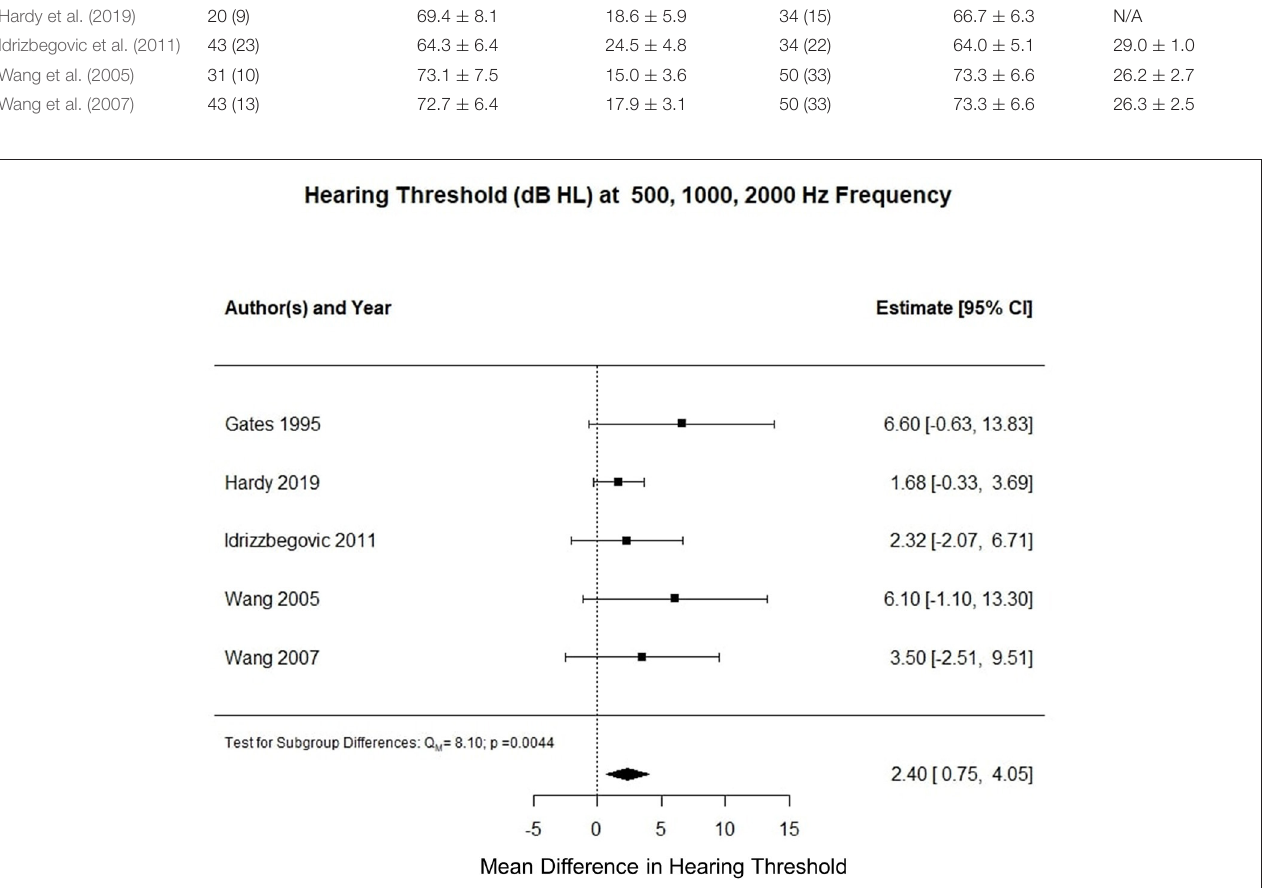
FIGURE 2 | Forest plot summarizing meta-analysis findings of hearing threshold (dB HL) difference between subjects with Alzheimer’s disease and control subjects at 0.5–2kHz PTA.